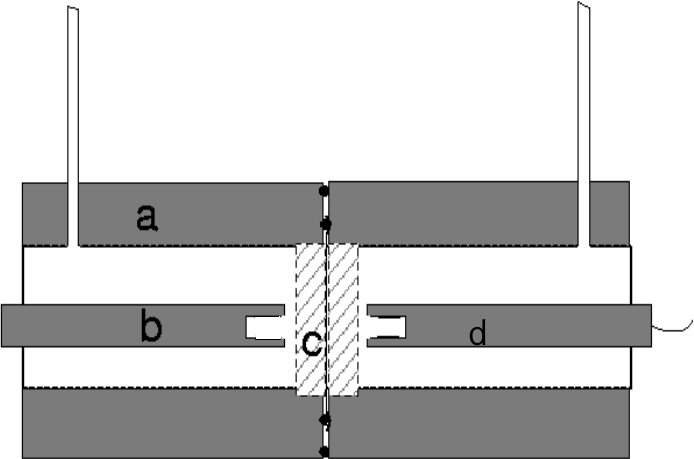
Figure 2. Cross-section of the osmotic cell. The cell parts highlighted are labelled ( a ) representing the cell body; ( b ) a Perspex insert; ( c ) the porous disc and ( d ) a conductivity probe. The polymer film is depicted as a fine line housed between the two discs.